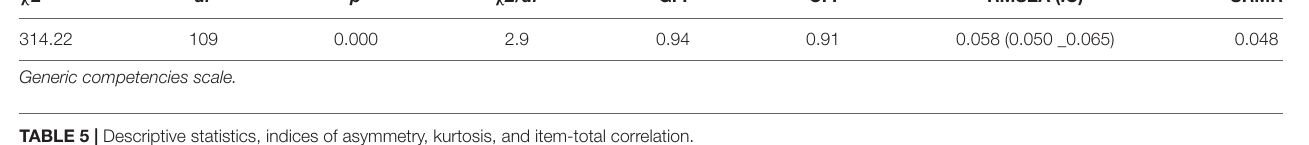
TABLE 5 | Descriptive statistics, indices of asymmetry, kurtosis, and item-total correlation.